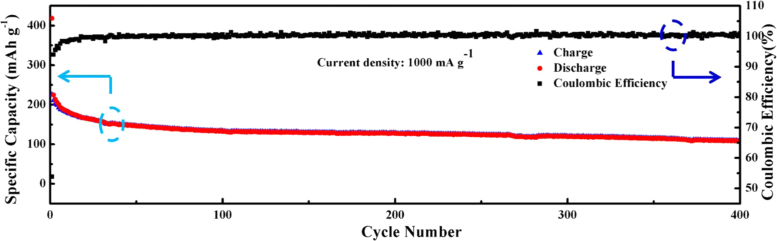
Electrochemical performance of Ni2P/NG/Ni2P composite.